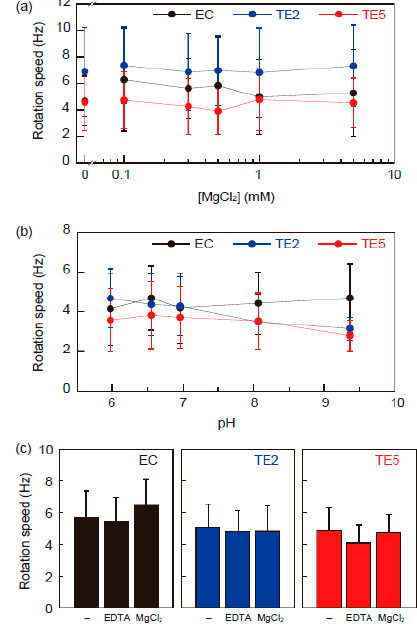
Figure 3. Rotational speed of single motors driven by chimera stators in E. coli . ( a ) Effect of Mg 2+ concentrations on the motor speed. Buffer contains 10 mM potassium phosphate (pH 7.0) and indicated MgCl 2 . In the absence of MgCl 2 , 0.1 mM EDTA was added to the buffer. ( b ) Effect of pH on the motor speed. 10 mM potassium phosphate buffer containing 10 mM EDTA was adjusted to the desired pH by titration with HCl or KOH. ( c ) Motor speeds of EC (left), TE2 (center), and TE5 (right) in HEPES-Tris buffer. EDTA and MgCl 2 indicate the buffers containing 10 mM EDTA and 10 mM MgCl 2 , respectively.